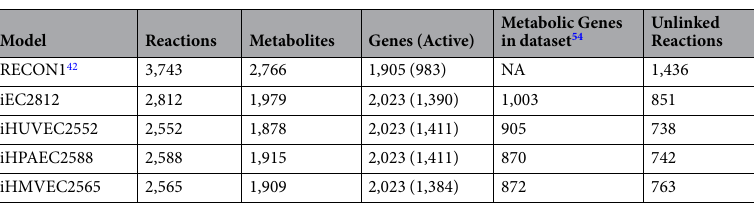
Table 1. The model components; reactions, total and those without a linked gene, metabolites, genes (total and inactive) of RECON1 42 , iEC2812 and endothelial specific subtype genome scale metabolic models and the genes in the data set linked to each